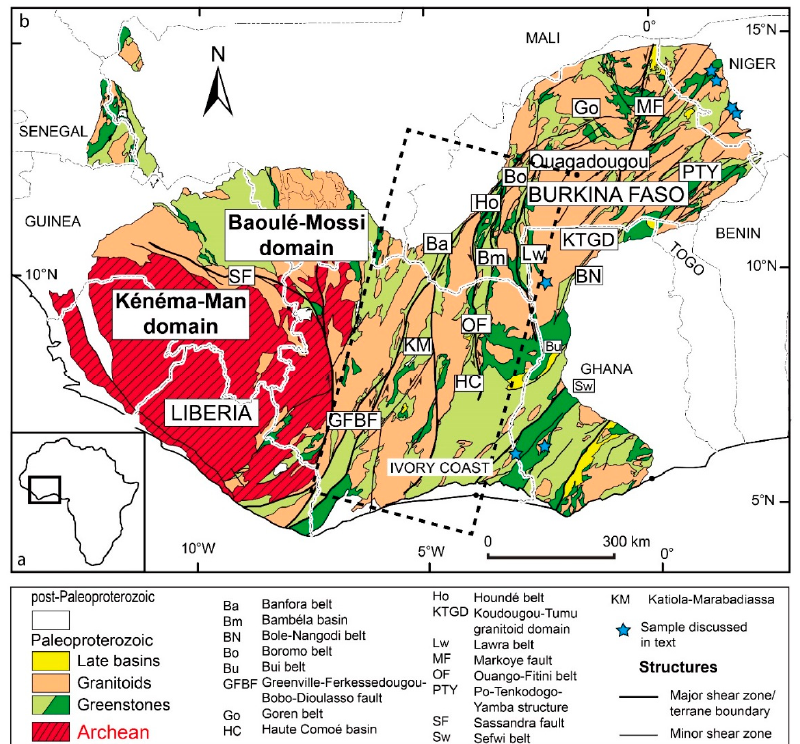
Figure 1. ( a ) Simplified map of Africa. ( b ) Simplified geological map of the Leo–Man Shield, modified after Milési et al. [24]. The Archaean basement is surrounded by greenstone ‐ granitoids belts. The samples (blue stars) used to estimate the mantle potential temperature (Tp) are collected from Ama Salah et al. [25]; Soumaila, [26]; Galipp et al. [27]; Hirdes et al. [28]; Thomas et al. [29]. More detailed information on the samples are provided in Tables 1 and